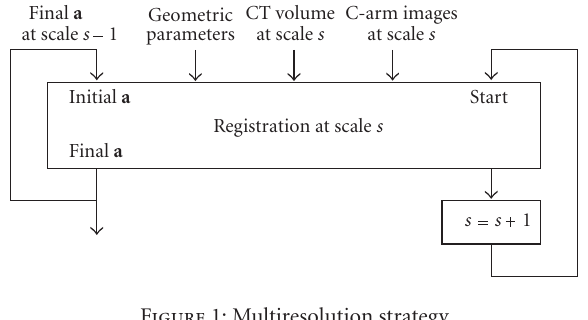
Figure 1: Multiresolution strategy.